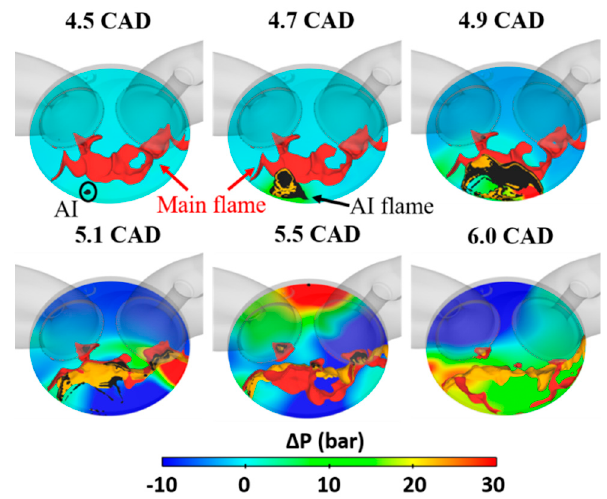
Figure 9. Evolution of main flame propagation and end-gas auto-ignition at ω = 0.5 by 3D isosurfaces of G = 0 and mass fraction of HCO = 3 ppm; the background color indicates the pressure evolution.